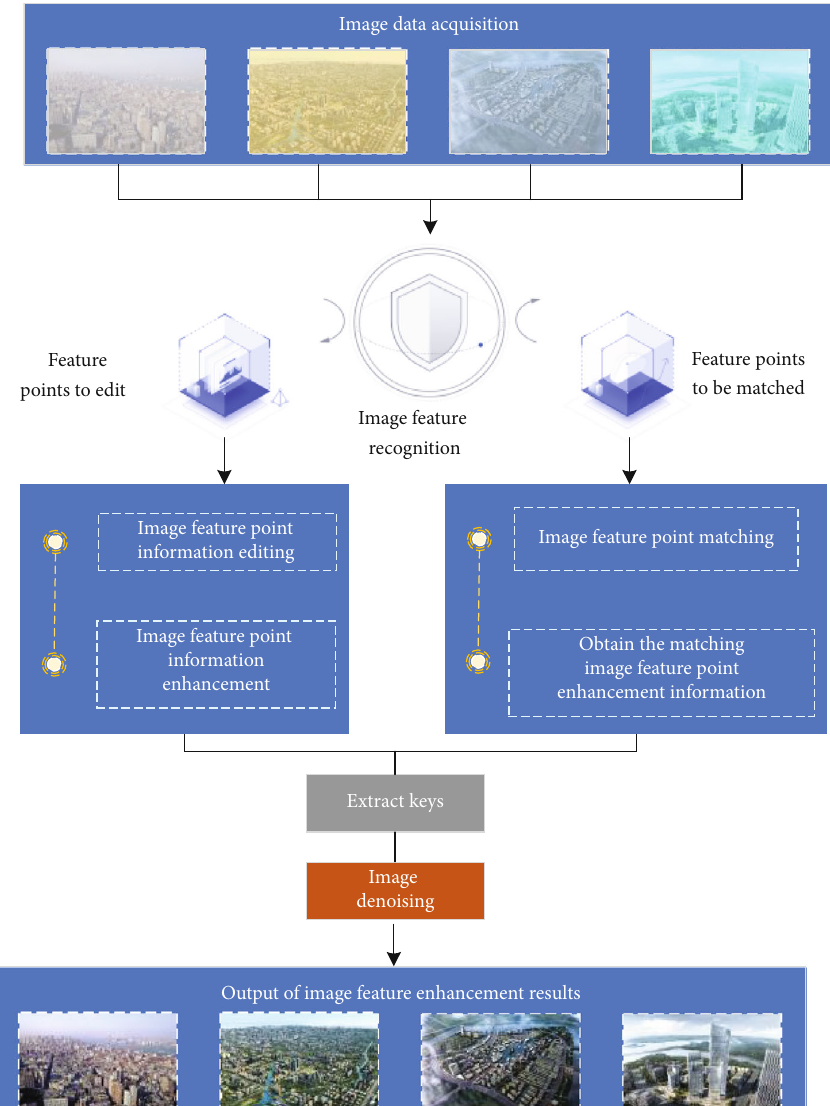
Figure 3: Overall architecture of image feature enhancement